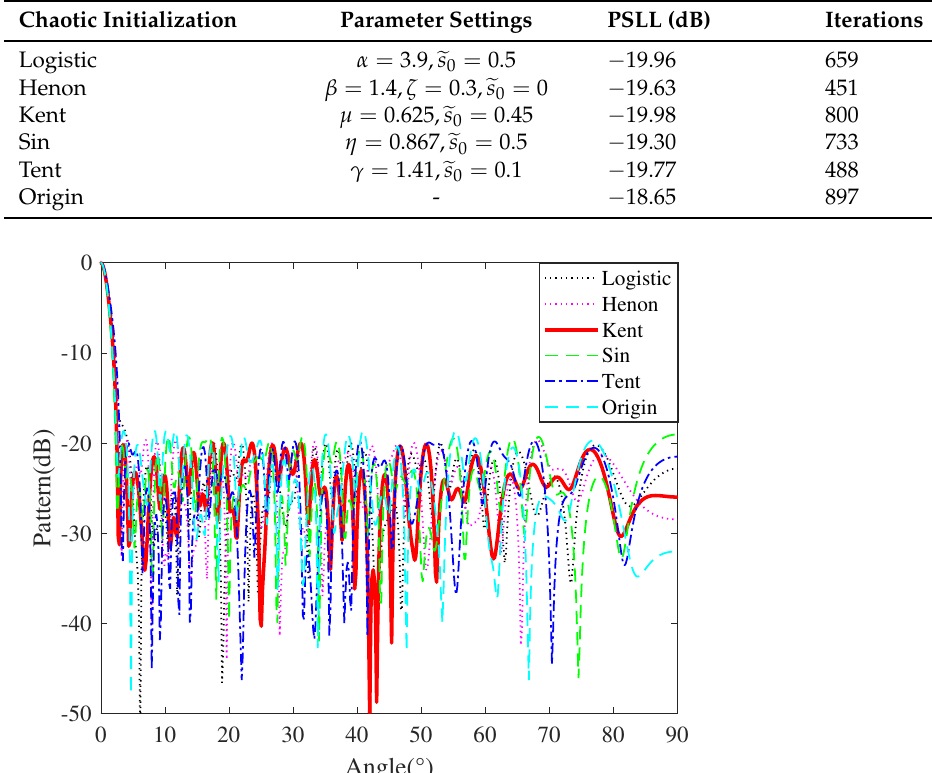
Figure 5. Beampatterns of the obtained array based on five chaotic initialization